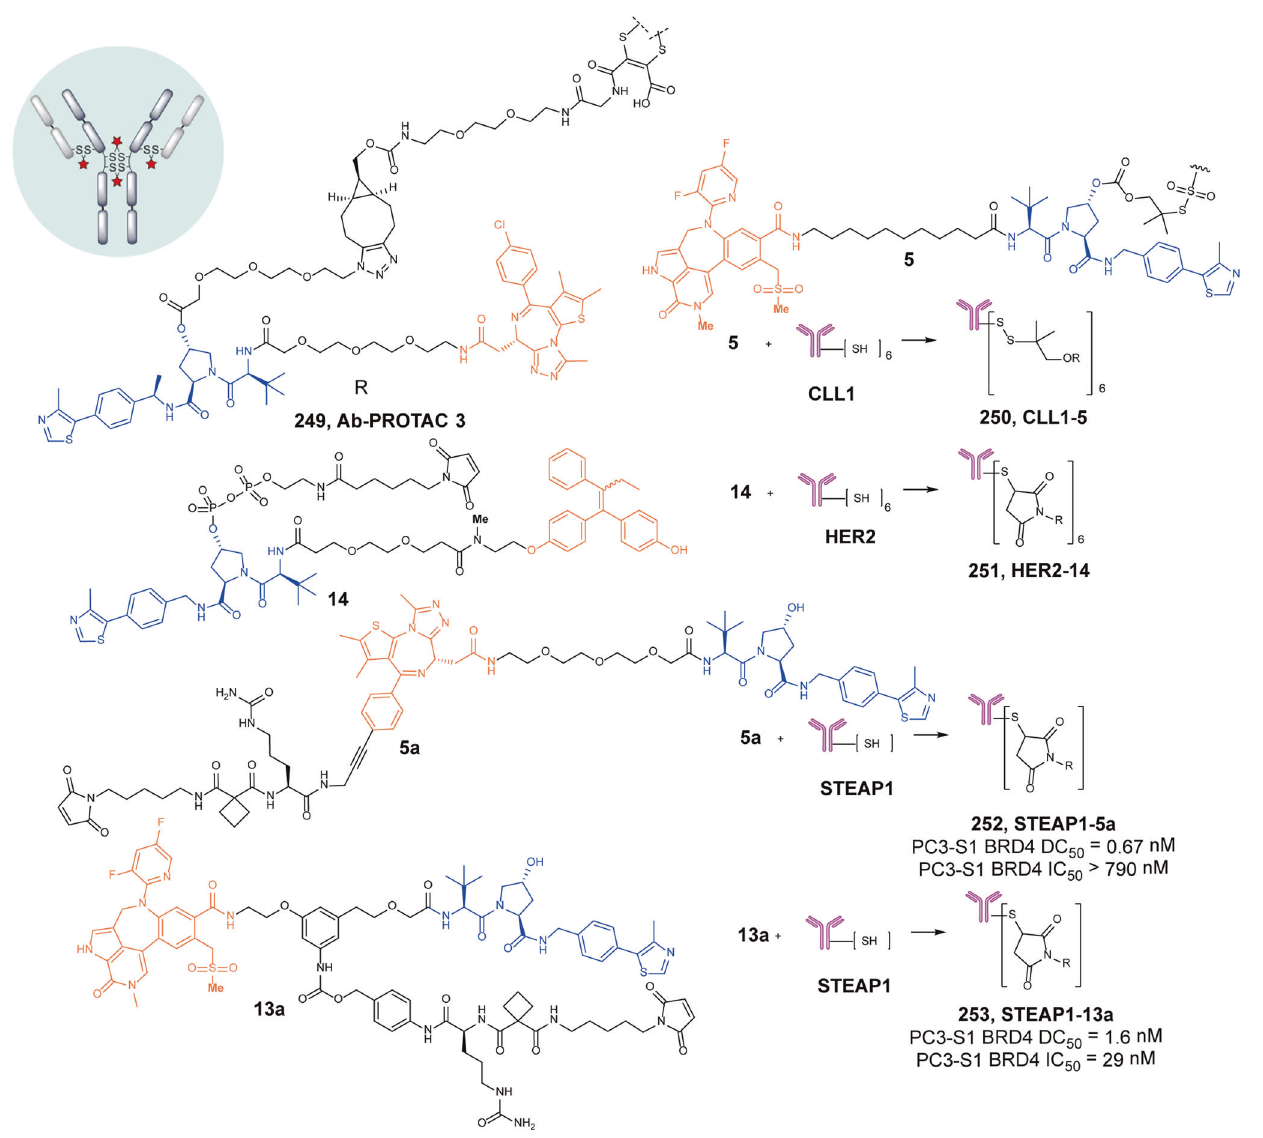
Fig. 82 The representative PROTACs of